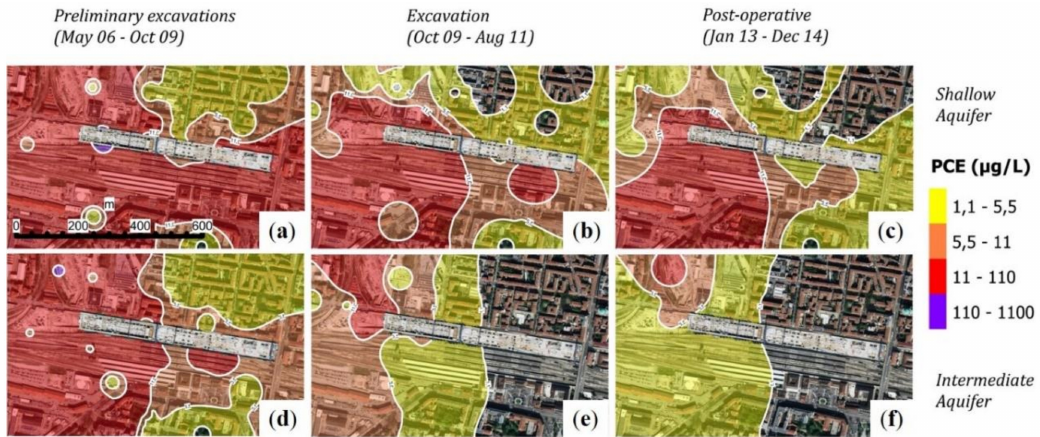
Figure 6. Contour maps representing values of tetrachloroethylene (PCE) concentration in the ( a–c ) shallow and ( d–f ) intermediate aquifers at three time instants.